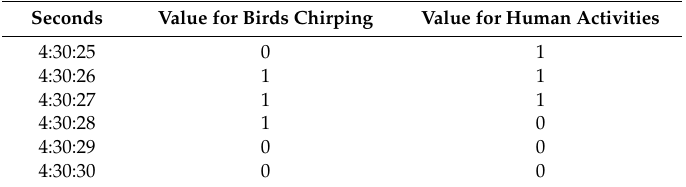
Table 5. Example of assigning 0 and 1 for the temporal correlation analysis of patterns.